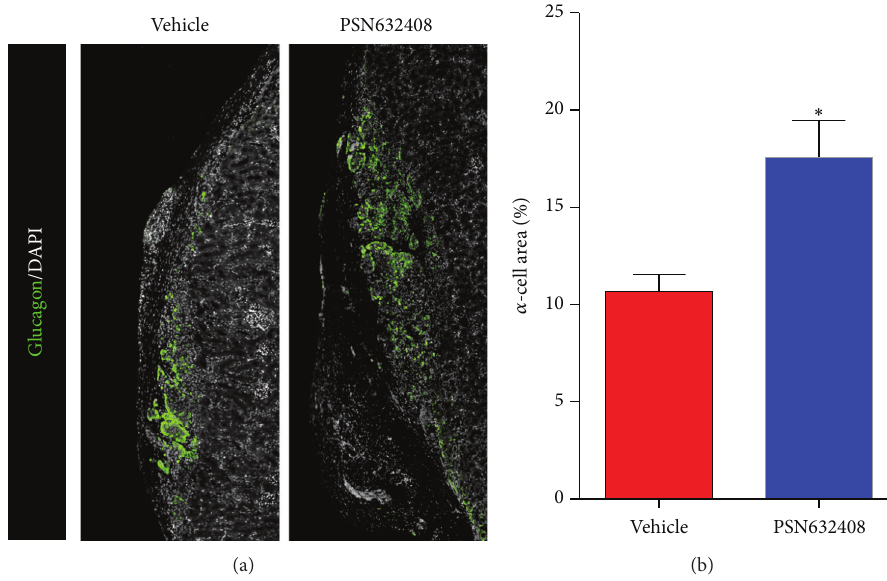
Figure 7: (a) Immunofluorescent staining for glucagon (green color) and DAPI (white color) in human islet grafts from PSN632408- and vehicle-treated mice with normoglycaemia at 4 weeks after transplantation. (b) Percentage of 𝛼 -cell area in human islet grafts. The 𝛼 -cell area in PSN632408-treated mice ( 𝑛 = 4 ) was significantly increased compared with vehicle-treated mice ( 𝑛 = 3 ) ( ∗ 𝑃 < 0.02